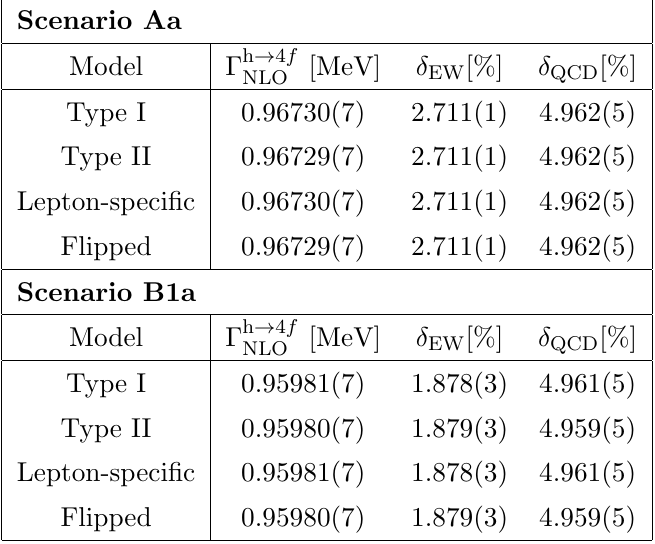
Table 10 . The h 4 f widths for the di(cid:11)erent types of THDM for scenarios Aa and B1a using the ! MS( (cid:21) 3 ) renormalization scheme. The numerical errors are given in parentheses.